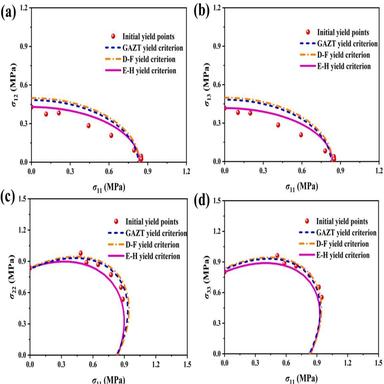
Comparisons between the yield points and three typical theoretical yield models of KV lattice structures in different stress planes: (a) σ11 − σ12; (b) σ11 − σ13; (c) σ11 − σ22 and (d) σ11 − σ33.